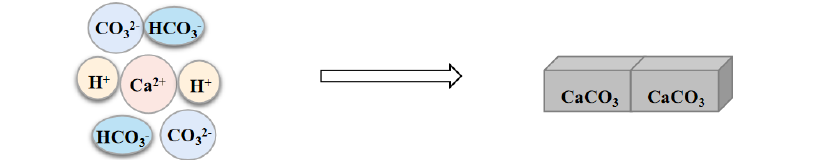
Figure 8. Deposition diagram of calcium carbonate scale as the main component in co-deposition.